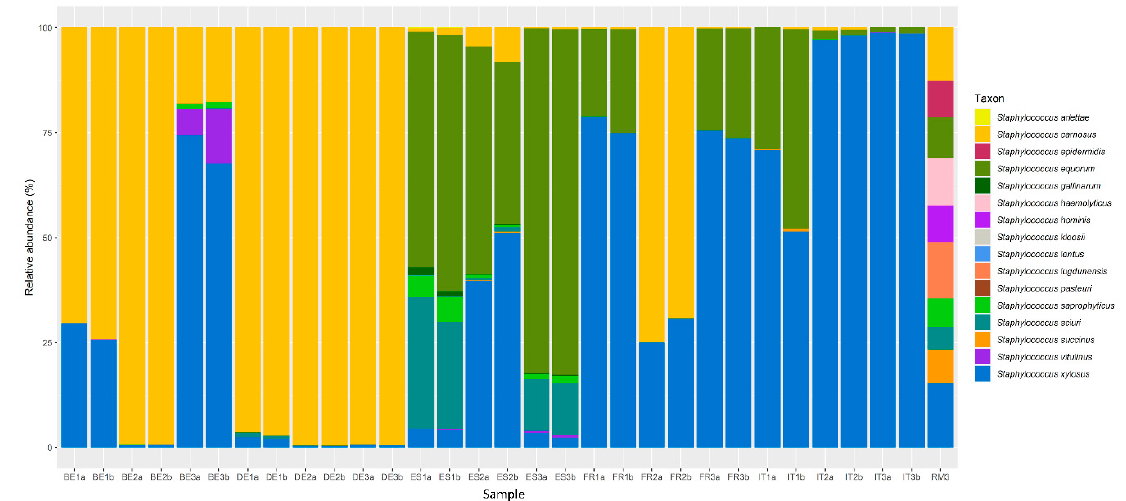
Figure 3. Distribution of amplicon sequencing variants (ASVs) of a partial region of the tuf gene assigned to staphylococcal species in selected commercial fermented meat products originating from BE (Belgium), DE (Germany), ES (Spain), FR (France), and IT (Italy), with “a” and “b” annotations in the sample names representing biological duplicate samples from the same product. RM3 represents the mock community used to check the performance of the PCR assay and subsequent